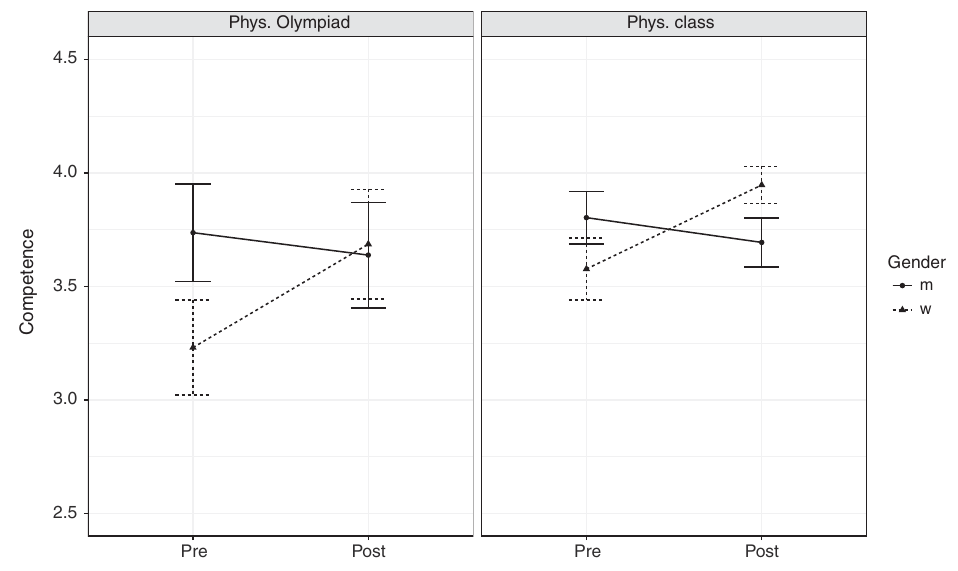
FIG. 5. Means and standard errors for competence over time with regard to